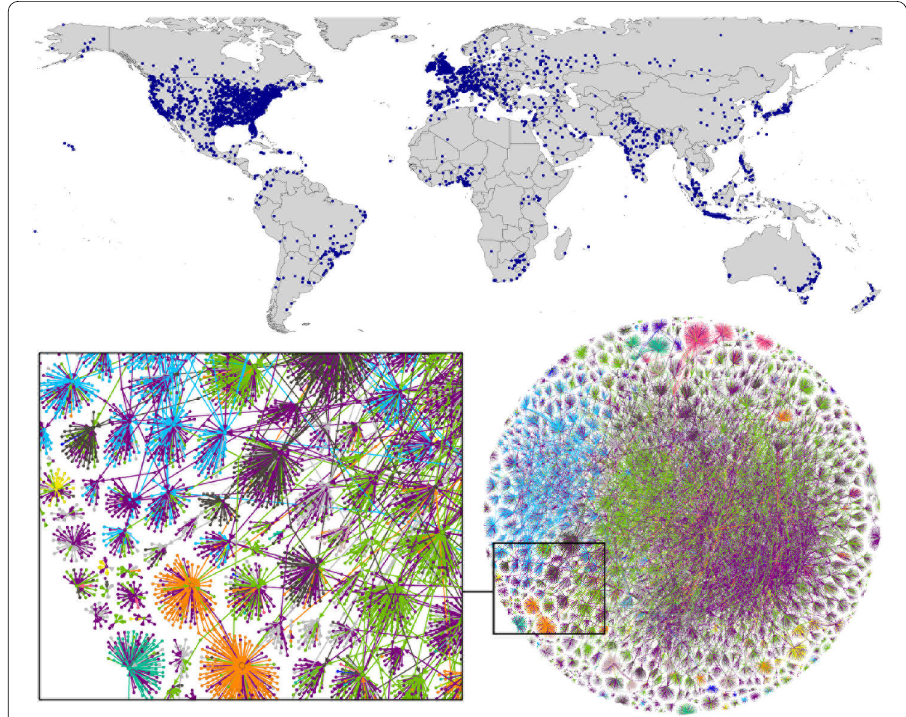
Figure 1 User locations in the Twitter social network. The top panel shows a map with the locations of the users in the dataset. The lower panel shows the ego network of locations including only precedingalters , with nodes colored according to the country as a way to illustrate locations. A clear country assortativity pattern can be observed (with a nominal assortavity coefficient for countries of 0.53), as most preceding alters of egos are in the same